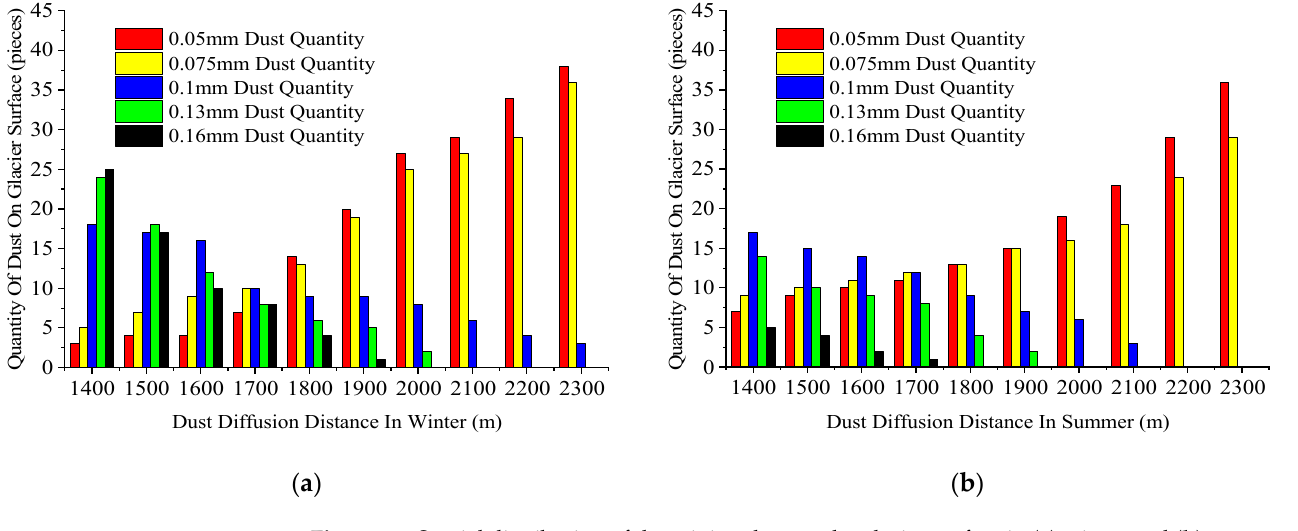
Figure 10. Spatial distribution of the mining dust on the glacier surface in ( a ) winter and ( b ) summer.